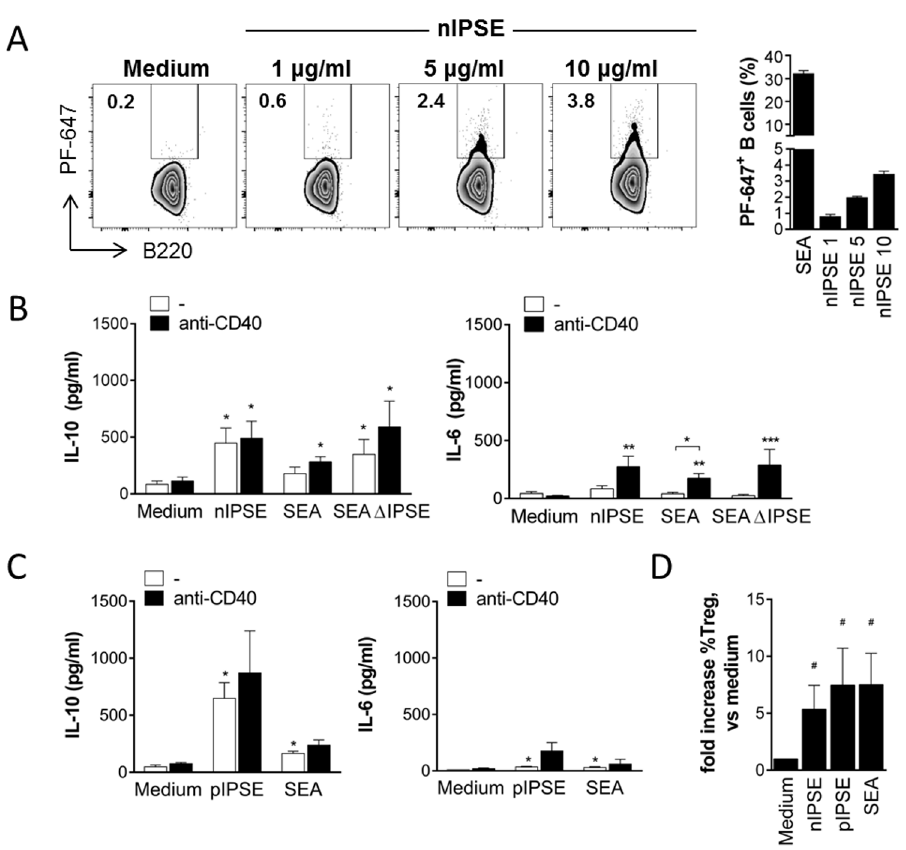
untreated and the frequencyof SEA- and IPSE-positive cells measuredafter 60 minutes by flow cytometry. Representative FACS plots and summary of 3 experiments is shown(N = 3). (B) Splenic B cells from na ï ve mice were culturedfor 3 days with 10 μ g/ml nIPSE, 20 μ g/ml SEA, 20 μ g/ml SEA Δ IPSE or medium as control, with or without additionof anti-CD40mAb (2 μ g/ml). Cytokineconcentration in supernatantsafter 3 days